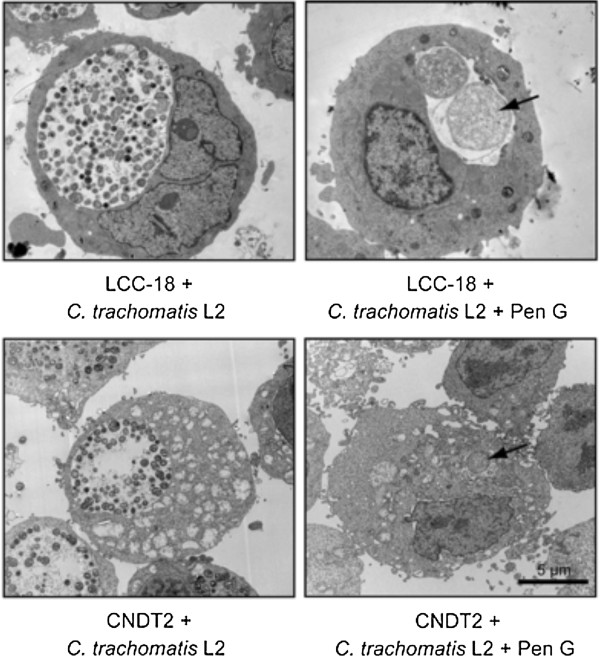
LCC-18 and CNDT-2 cells actively and persistently infected with Chlamydia trachomatis L2. Growth of C. trachomatis, manifested through inclusions containing both elementary bodies (EB) and reticulate bodies (RB) at 24 h post infection (p.i.), could be observed in both cell lines. In EEC treated with penicillin G enlarged, aberrant bacteria (arrows) reminiscent of persistent growth forms can be seen.